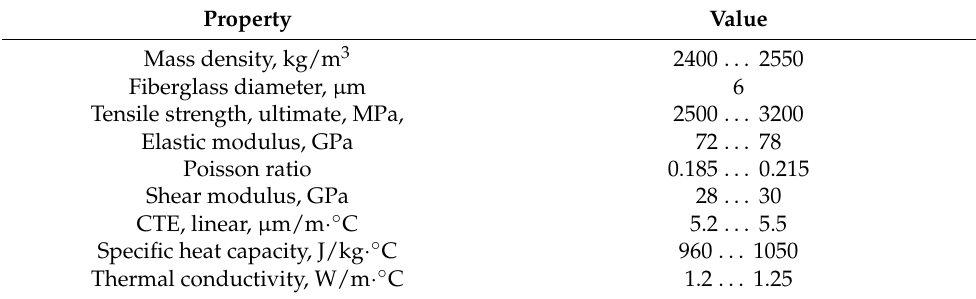
Table 1. Physical and mechanical properties of E-glass fiber.